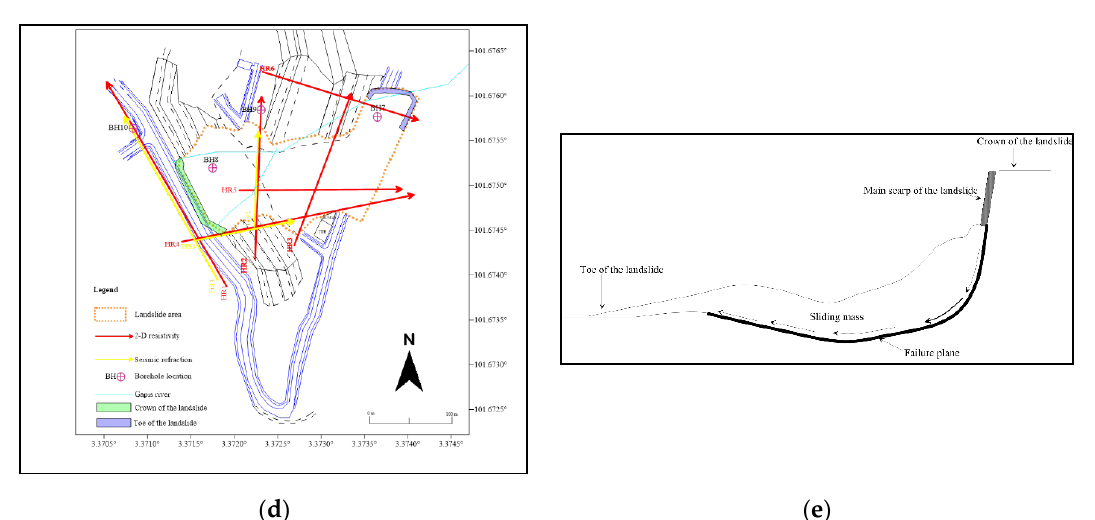
Figure 1. Ulu Yam study area: ( a ) landslide prone area in Malaysia-not to scale (modified from [34]); ( b ) geological setting of Peninsular Malaysia (modified from [56,57]); ( c ) geology map (modified from [58]); ( d ) study area (the survey lines of two-dimensional (2-D) resistivity and seismic refraction was shown with red and yellow line respectively); ( e ) schematic diagram of the rotational-landslide of Ulu Yam.